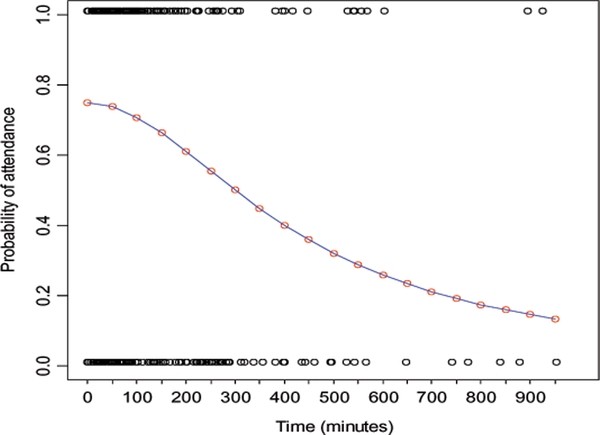
Probability decay function for the MIS survey showing probability of attendance (y-axis) for treatment seeking group against increasing travel times (x-axis); Y = C/(1 + e(A-x)/B) where C (0.766) is the limiting function on the y-axis; A (3.736) is the asymptote factor at the inflection point of the model; B (-0.609) is the decay parameter. The model was run using log transformed travel time (x-axis) and later back transformed for presentation purposes. The attendance pattern (1 = attendance and 0 = non-attendance) is also superimposed on the decay curve. The coefficient of all parameters were significant at p < 0.001.